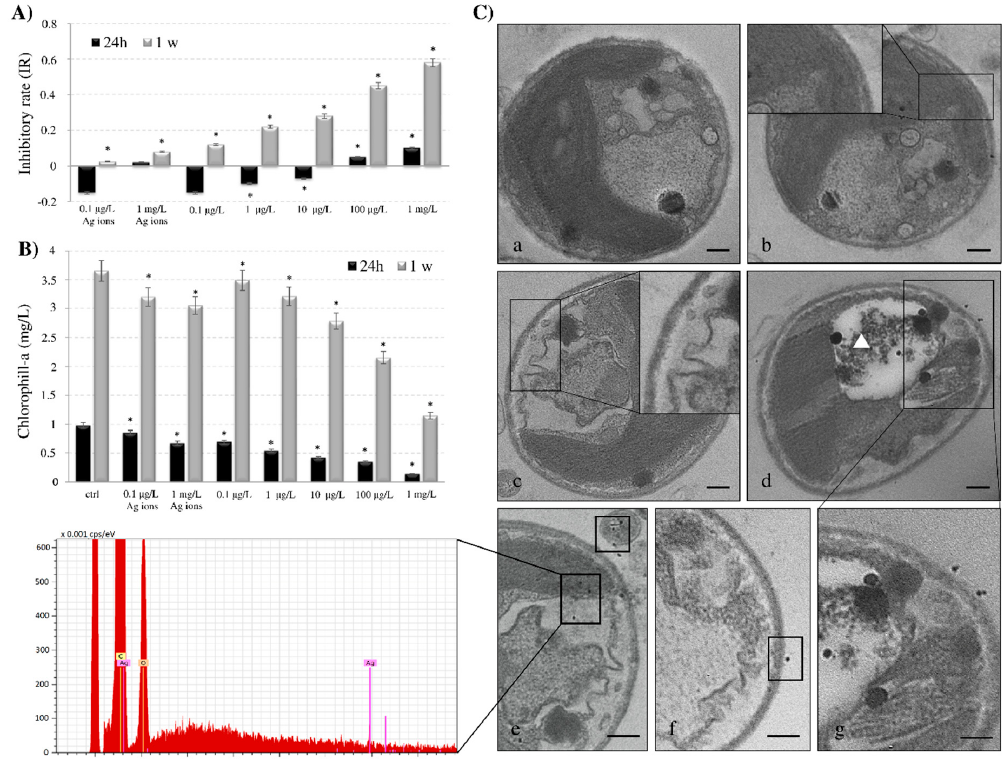
Figure 3. ( A ) Analysis of inhibitory rate. Algae were incubated for 24 h and a week with Ag ions and with five concentrations of AgNPs-G. Data were analysed by performing one-way ANOVA at the 95% confidence level. Each value represents the mean ± SD of 3 technical replicates in each of the 3 independent experiments. Asterisks indicate significant differences from the control values ( p < 0.05); ( B ) Analysis of chlorophyll-a content by spectrophotometric analysis of centrifuged samples. Quantitative determination was done according to Arnon et al. (1949). The experiments were conducted in triplicate and results are the mean with standard deviation. Asterisks indicate significant differences from the respective untreated samples ( p < 0.05) ( C ) TEM micrographs of algal cells and elemental X-ray spectrum (lower panel) of the square area of micrograph ( e ) containing black spots. ( a ) control cell; ( b ) algal cells treated with Ag ions. ( c ) algal cells treated with AgNPs-G for 24 h. Plasma membrane detaches from the cell wall, as indicated in the magnification; ( d – g ) Algal cells treated with AgNPs-G for a week. AgNPs-G were observed inside large vacuoles ( d , white triangle), inside algae ( d – e ) or crossing the cell wall ( f – g ). Bar = 500 nm. EDX microanalysis (Figure 3C) confirms that the electron-dense particles observed inside the microalgae correspond to AgNPs. Interestingly, once inside the microalgae, the NPs are not released back into the medium, either as an active secretion or cell ruptures. The Ag content of algae filtrates analysed by ICP–OES correlated to the AgNPs-G amounts used for treatments and the time of exposure. The continuous internalisation of AgNPs-G particles observed in our experiments could be dependent on the size and dispersion of our NPs preparation. Data in literature report that bio-adsorption of heavy metal particles to algae is dependent on different properties of NPs, such as surface charge or size, chemical composition, and by the cell walls pore sizes, spanning through the thickness of the walls, ranging from 5 to 20 nm [62,64]. Thus, small nanostructures are highly diffusible, and only NPs up to 20 nm can reach the cell membrane. Other physicochemical properties of AgNPs can influence the internalisation, the rate of entrance and the biological response. Once the cell wall is penetrated, endocytic passage through plasma membrane may be possible and internalised NPs enhance biological effects. Sendra et al. [61] found that the